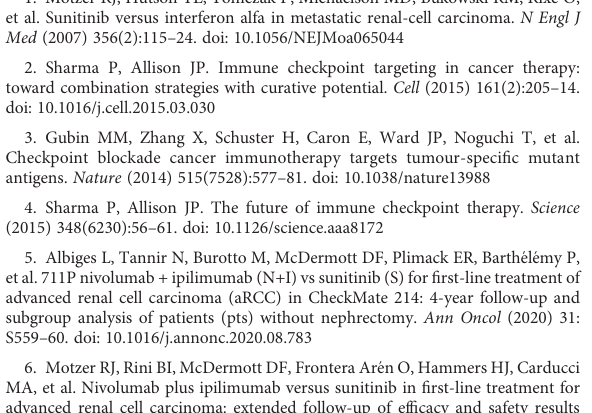
SUPPLEMENTARY FIGURE 1 Overall survival of mRCC patients using reconstructed survival data derived from fi ve individual studies with immune-oncology based combination therapy. SUPPLEMENTARY FIGURE 2 Progression-free survival of mRCC patients using reconstructed survival data derived from fi ve individual studies with immune-oncology based combination therapy. SUPPLEMENTARY FIGURE 3 Duration of response of mRCC patients using reconstructed survival data derived from fi ve individual studies with immune-oncology based combination therapy. SUPPLEMENTARY FIGURE 4 Overall survival of intermediate/poor mRCC patients using reconstructed survival data derived from fi ve individual studies with immune-oncology based combination therapy. Only data from CheckMate 214 and KEYNOTE-426 are included. SUPPLEMENTARY FIGURE 5 Progression-free survival of intermediate/poor mRCC patients using reconstructed survival data derived from fi ve individual studies with immune-oncology based combination therapy. Only data from CheckMate 214 and KEYNOTE-426 are